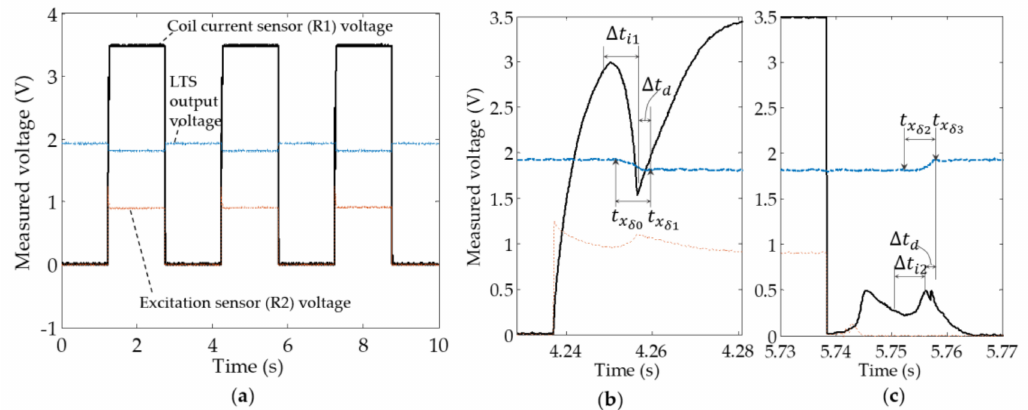
Figure 7. Multiple-cycle acquired data: ( a ) Illustration of multiple on–off cycles; ( b ) Obtaining of the desired section of data during air gap closing; ( c ) Obtaining of the desired section of data during air gap